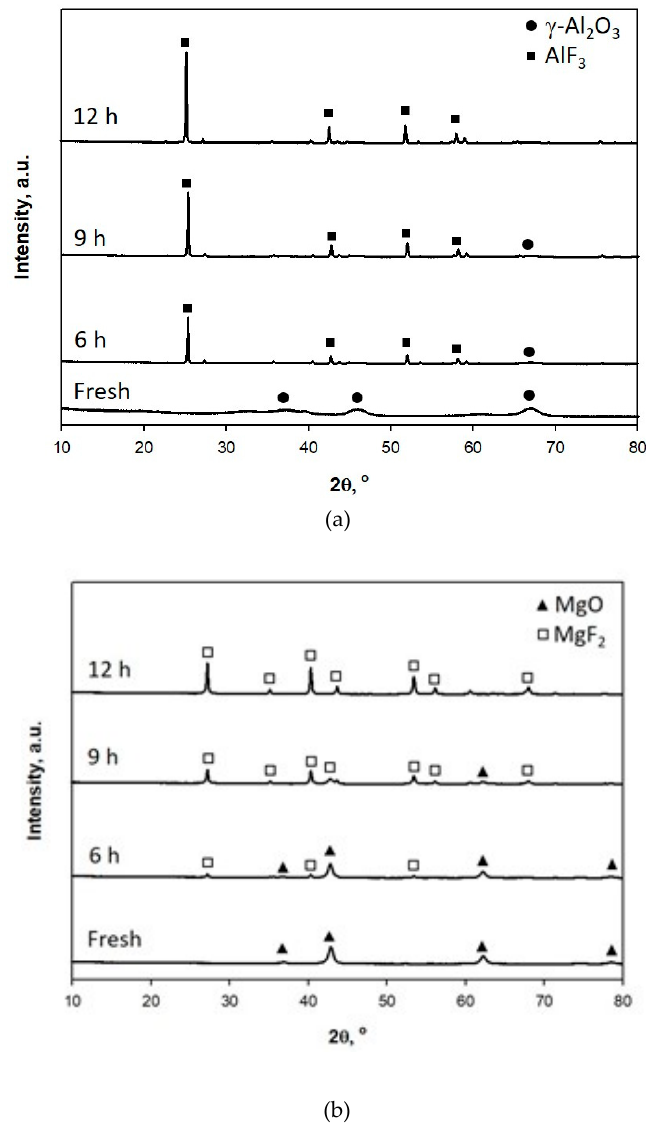
Figure 6. The XRD results of fresh and spent ( a ) γ -Al 2 O 3 and ( b ) MgO used in DB- γ -Al 2 O 3 -0.6-MgO- 0.6.